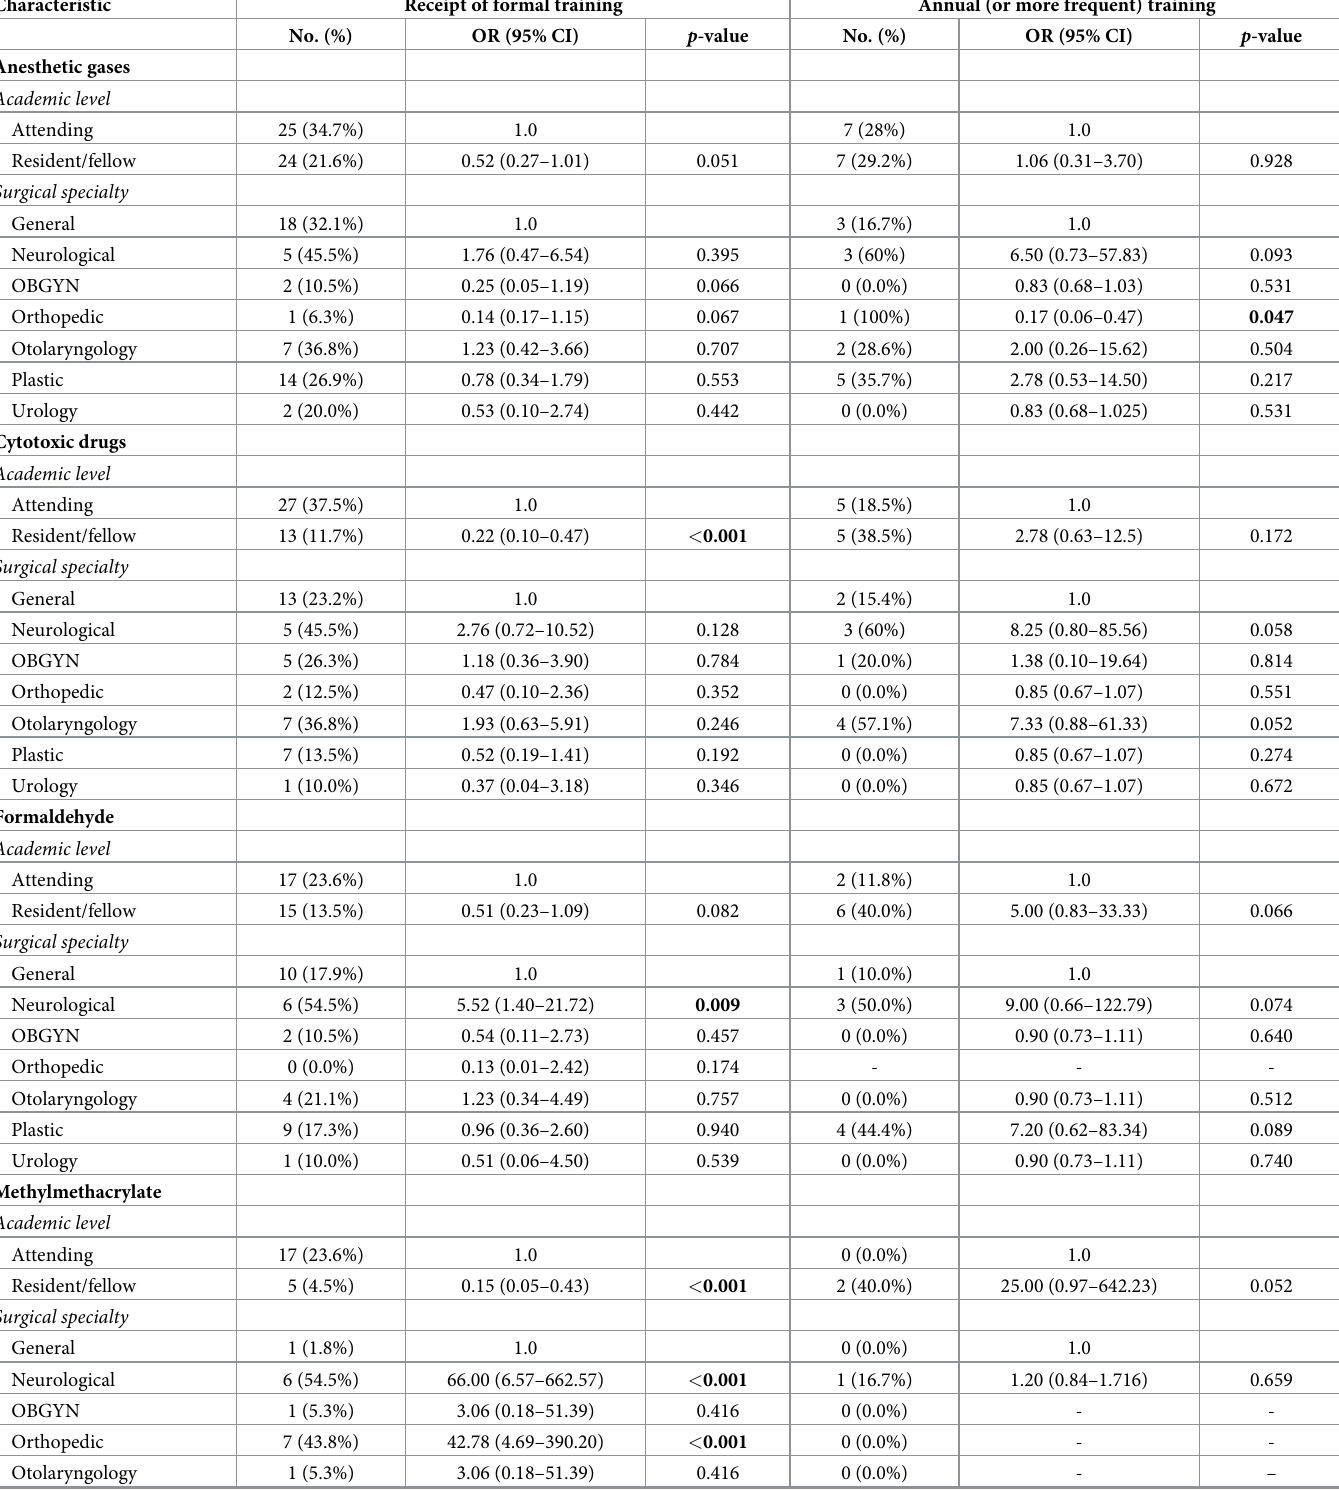
Table 2. Receipt and frequency of formal training for chemical occupational hazards stratified by academic level and surgical